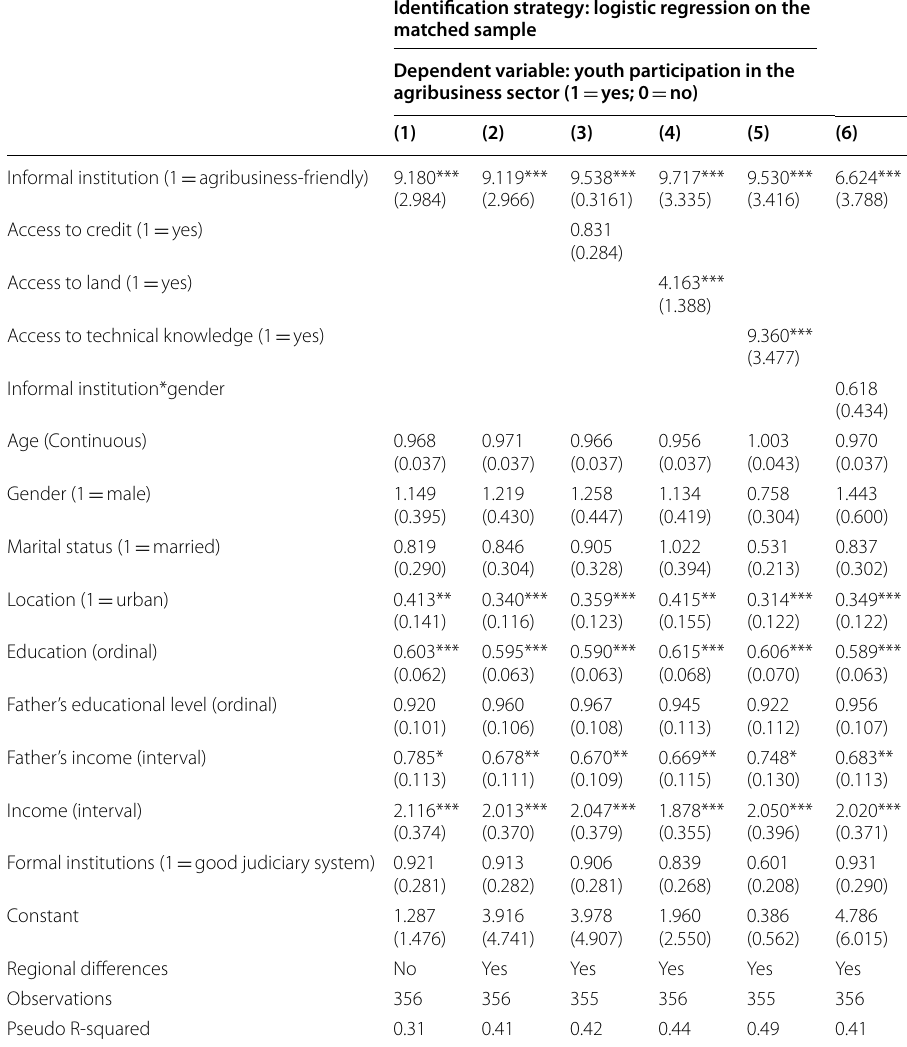
Table 6 Estimate impacts of informal institutions on youth participation in the agribusiness sector from regression’s framework. Source : Authors’ computations,